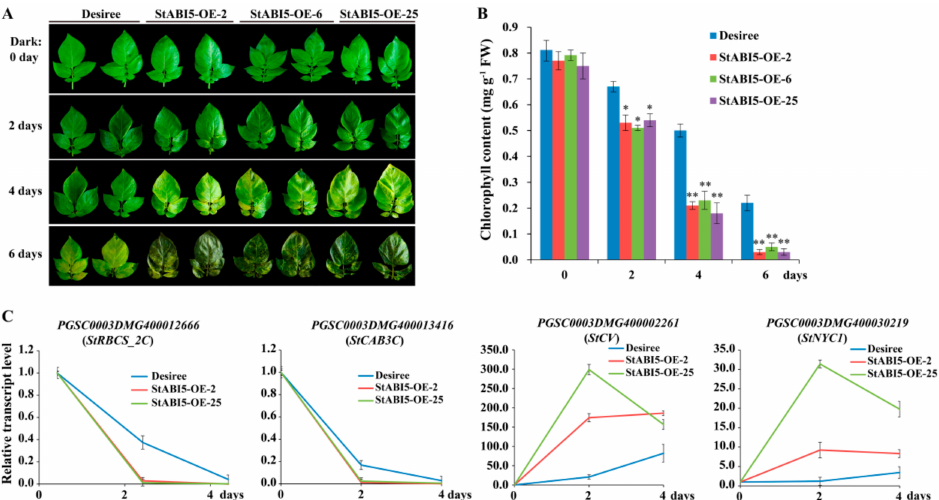
Figure 3. StABI5 regulates chlorophyll catabolism under dark conditions in potato. ( A ) Overexpressed StABI5 (StABI5-OE)transgenicpotatoleavesaccelerateyellowingandsenescenceunderdarkconditions. ( B ) Chlorophyll contents of StABI5-OE transgenic potato and Desiree leaves under dark conditions. The data represent an average of five leaves with three duplicates. Error bars indicate ± SD for triplicates.